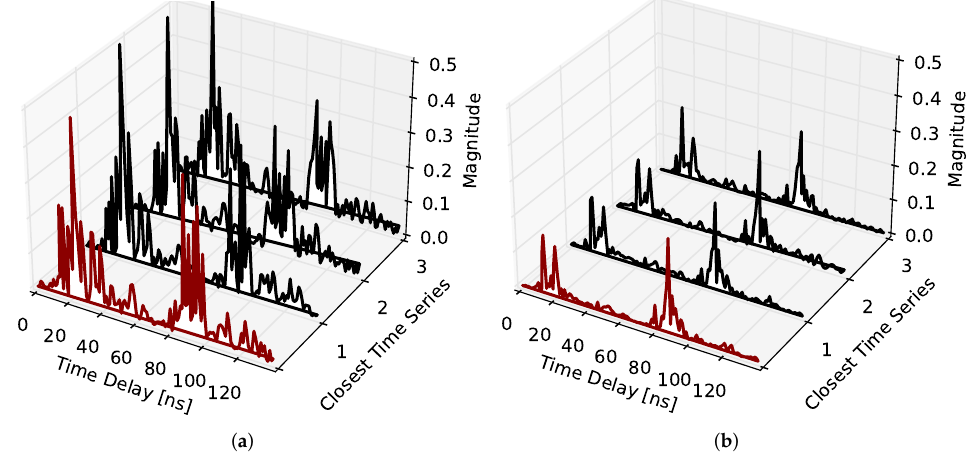
Figure 10. Example time series of the testing dataset (red) with the three closest neighbors from the training dataset (black) considered for the classification: ( a ) seat 1 occupied by a passenger (IV) and ( b ) Table 3 in use